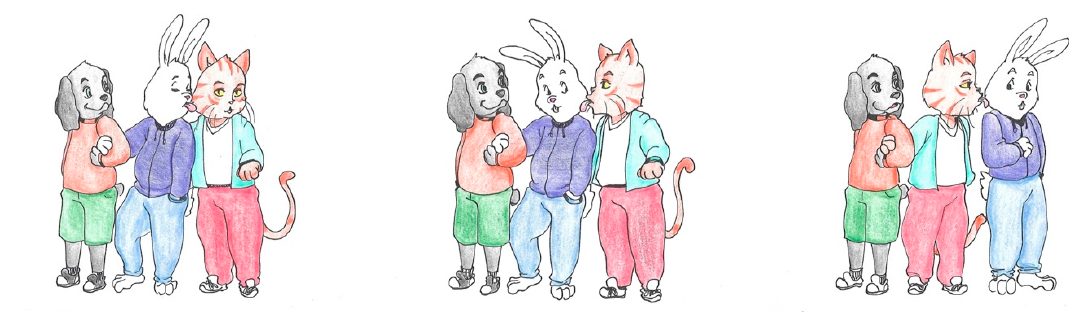
Figure A23. ORC stimulus 8.